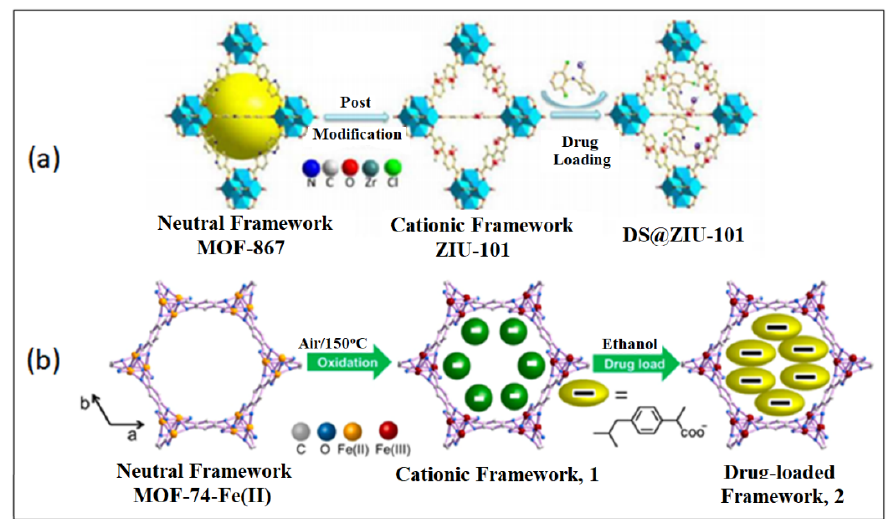
Figure 9. Examples of ion-responsive chemically modified BioMOF nanostructures. ( a ) Ionic-modi- fied MOF-867. Reproduced with permission from Ref. [182]. Copyright © 2014, American Chemical Society. ( b ) Oxidative procedure of MOF-74-Fe(II). Reproduced with permission from Ref. [183]. Copyright © 2016, American Chemical Society.